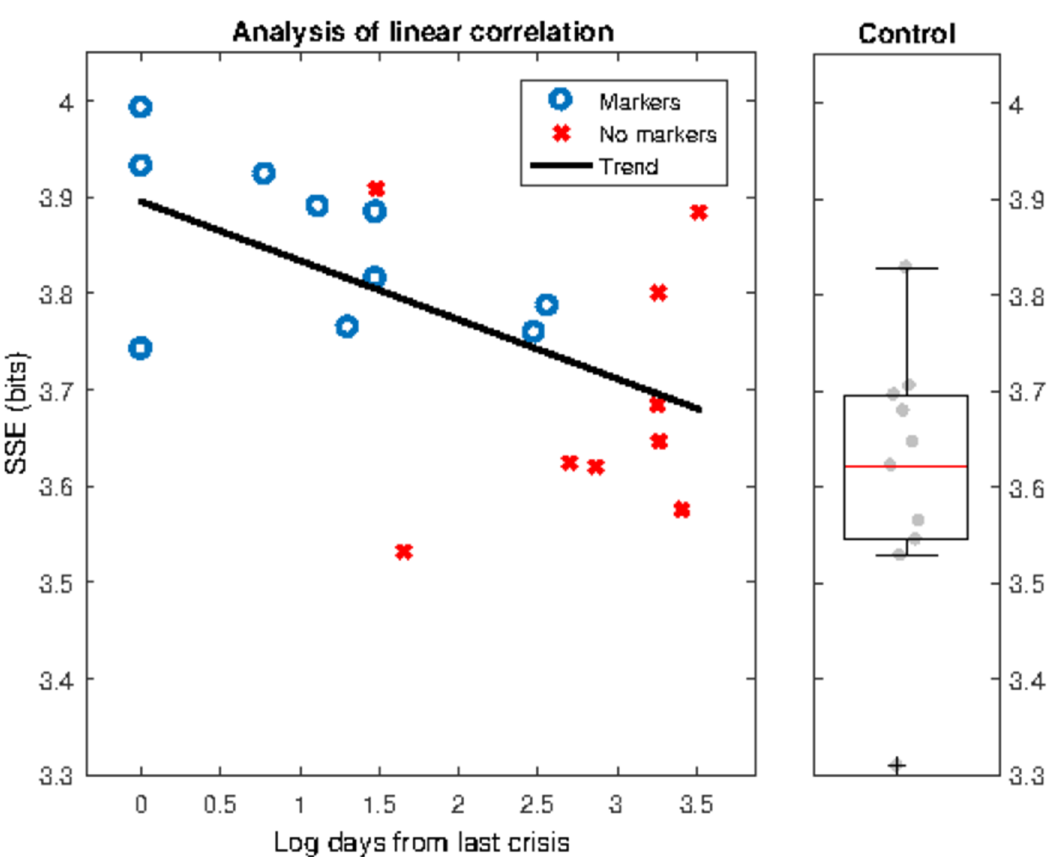
Fig 8. Linear fit of SSE vs time elapsed ( log 10 ) from last crisis (left) and boxplot of the SSE of healthy subjects in the band of frequencies of interest (right). The fit suggeststhat the SSE decreases as the time from the last crisis increases.Moreover, it shouldbe noted that the SSE values seems to asymptotically converge in time to the levels of control